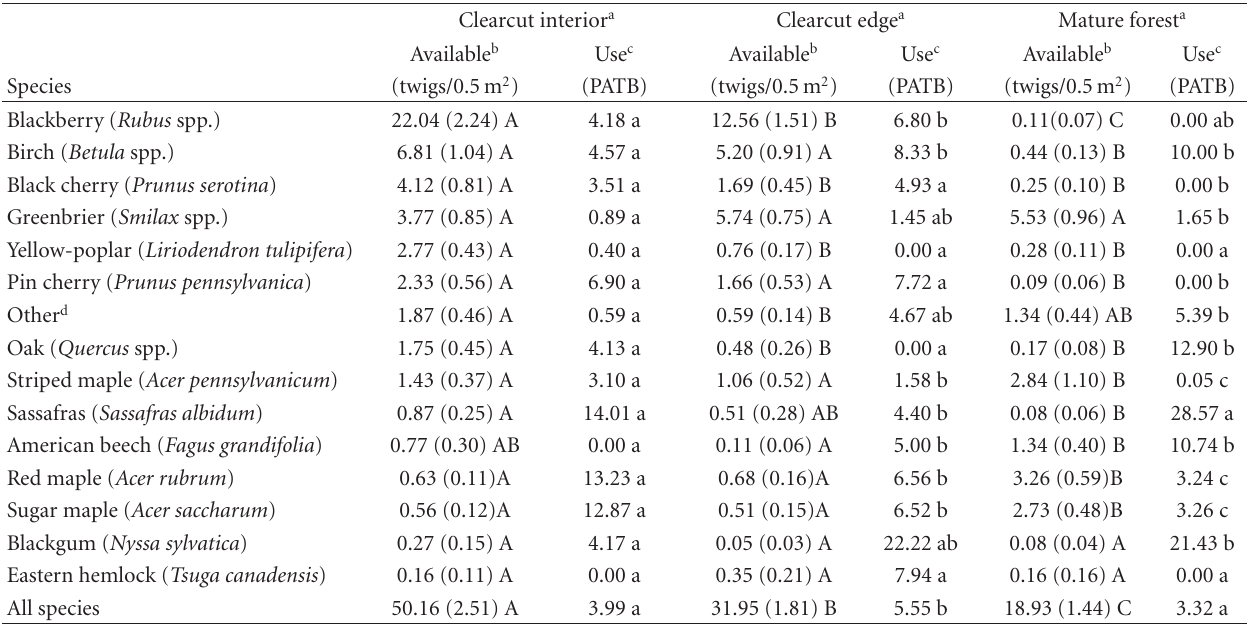
a n = 180 plots in each type. b